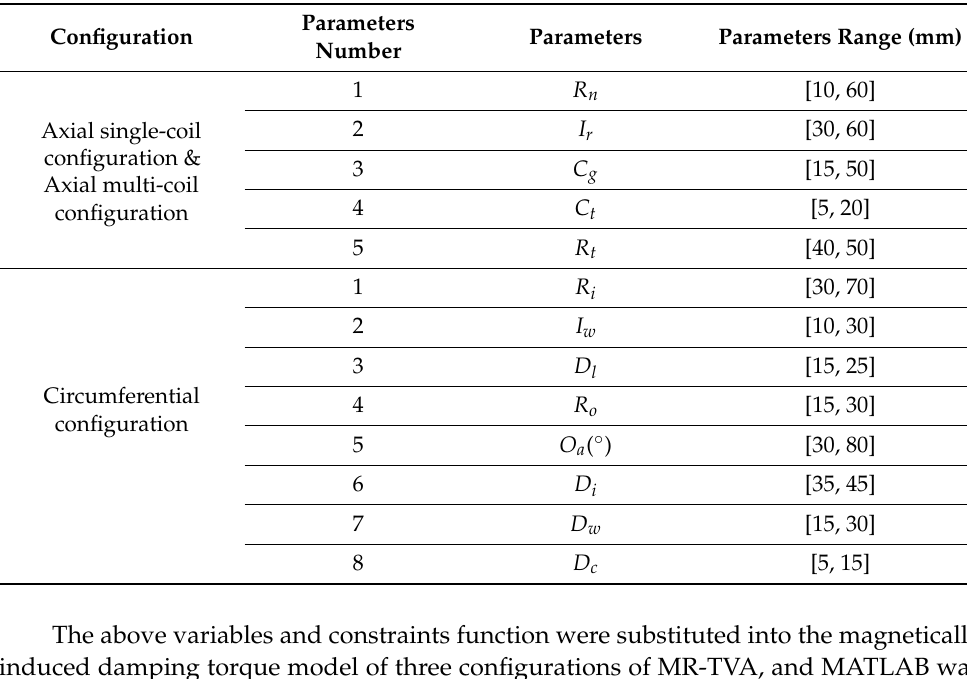
Table 6. Allowable values of the design variables for MR-TVA.